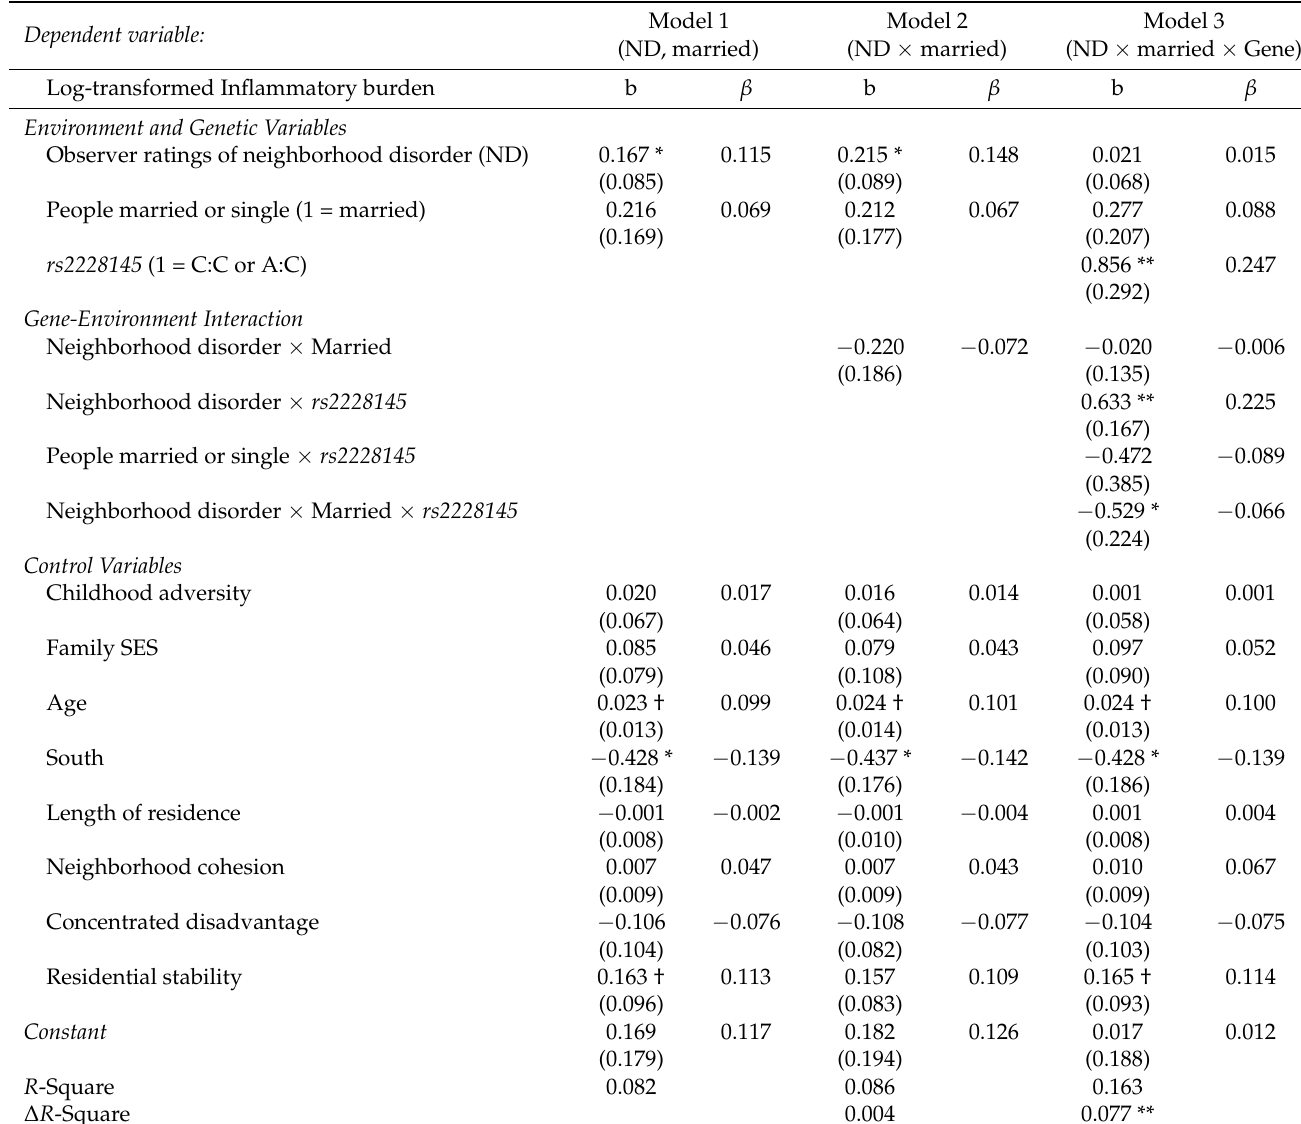
Table 5. Regression analysis examining the relationships among neighborhood disorder, rs2228145 , marital status, and inflammatory